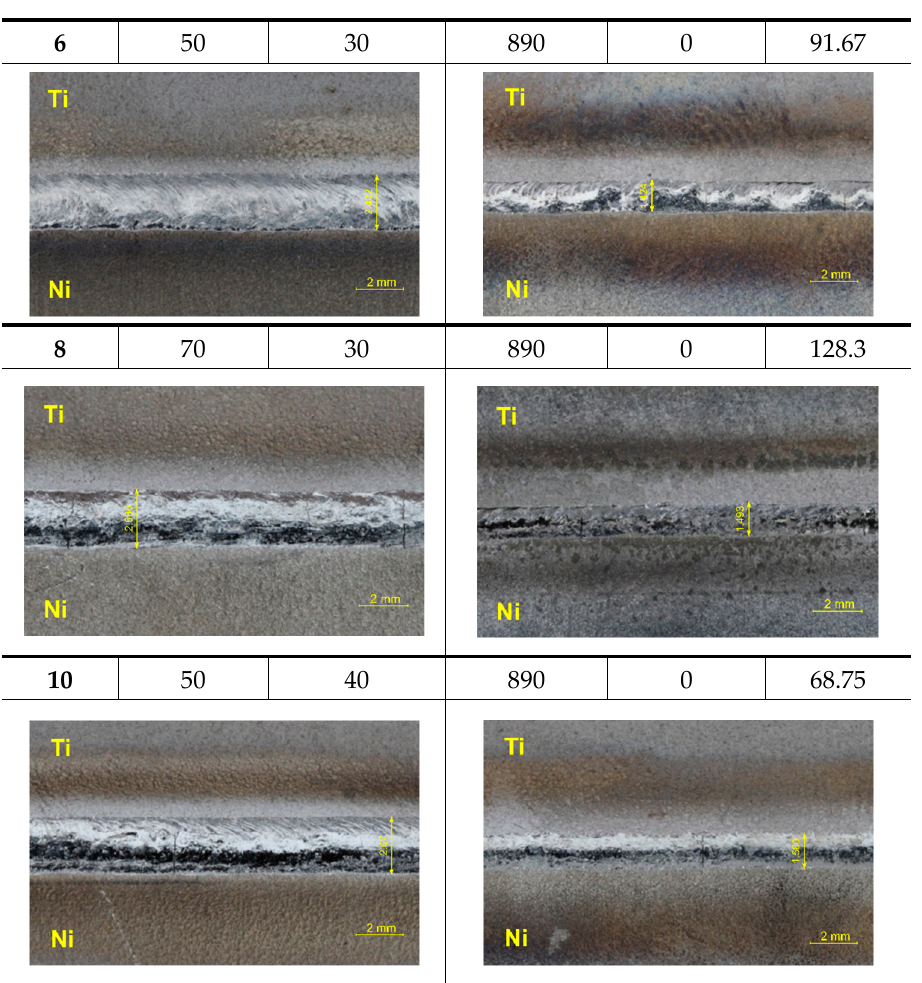
Figure 4. Weld bead and root view for joints produced with electron beam welding with different parameters (samples 1, 6, 8, 10). Table 7. Measured widths of the bead and root for dissimilar weld joints. Welded Joint No.